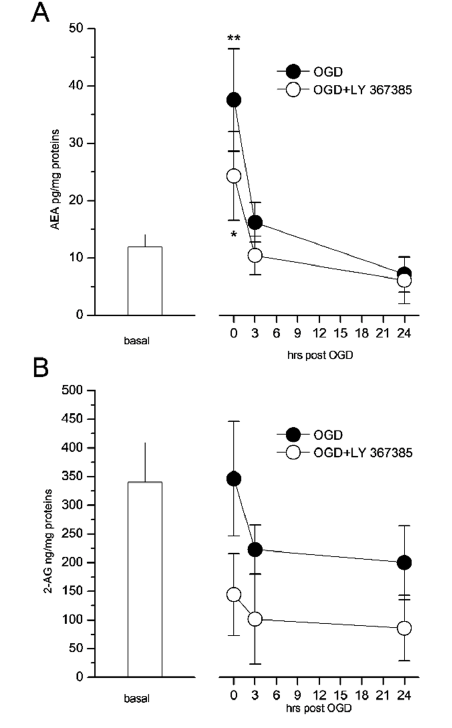
Figure 5. The mGlu1 receptor antagonist LY367385 reduces the formation of the endocannabinoids AEA and 2-AG in organotypic hippocampal slices exposed to 30 min OGD. ( A ) The contents of AEA were transiently increased immediately after OGD and the returned to basal levels. LY367385 was able to reduce the transient increase. ( B ) The contents of 2-AG were not changed after OGD, but LY367385 was still able to reduce its levels. AEA and 2-AG were measured in 8 dorsal hemisections/sample. LY367385 was present in the incubation medium during the 30 min OGD exposure and the subsequent recovery period. * p < 0.05 and ** p < 0.01 vs. OGD alone and control, respectively (ANOVA + Tukey’s w test).